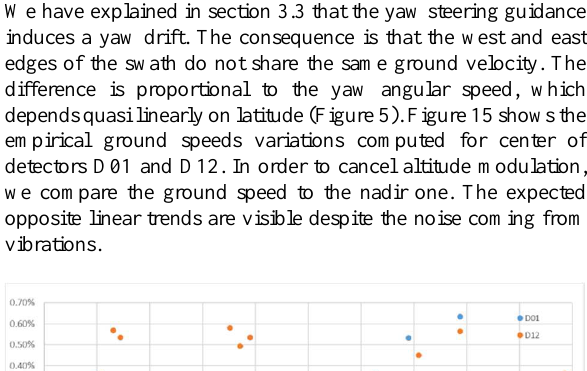
Figure 14 : Modulation amplitude (peak to peak) of different band couples on S2B. The susceptibility depends on the time delay.